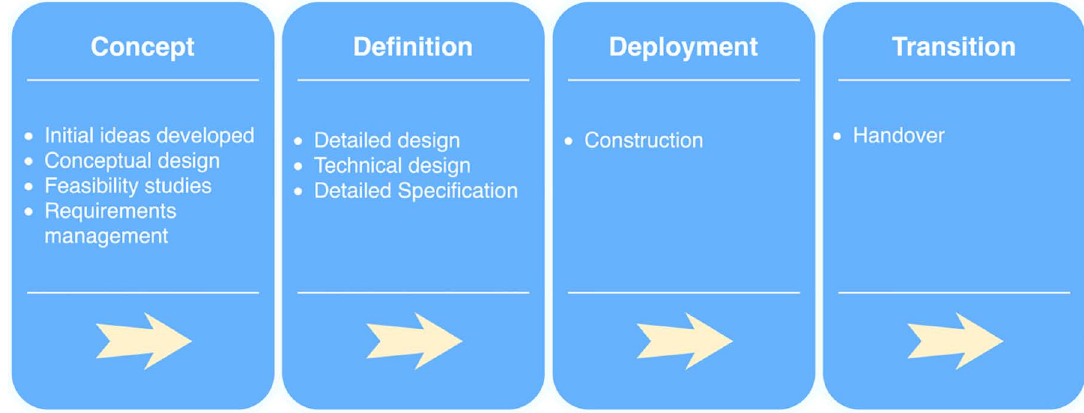
Figure 1. Project Lifecycle Adapted from APM Body of Knowledge 7th Edition (Source: Association for Project Management,